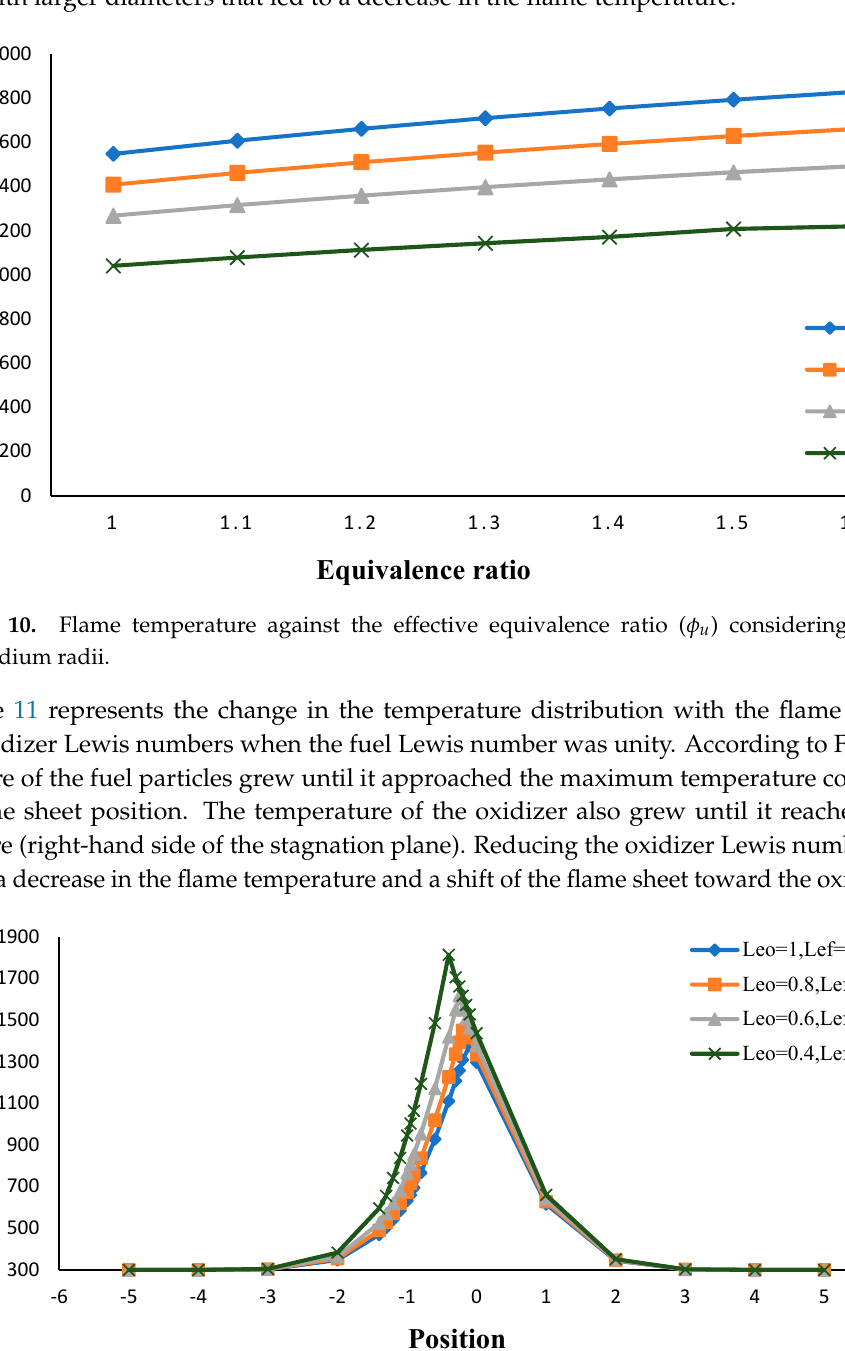
Figure 11. Temperature distribution against position for different oxidizer Lewis numbers.